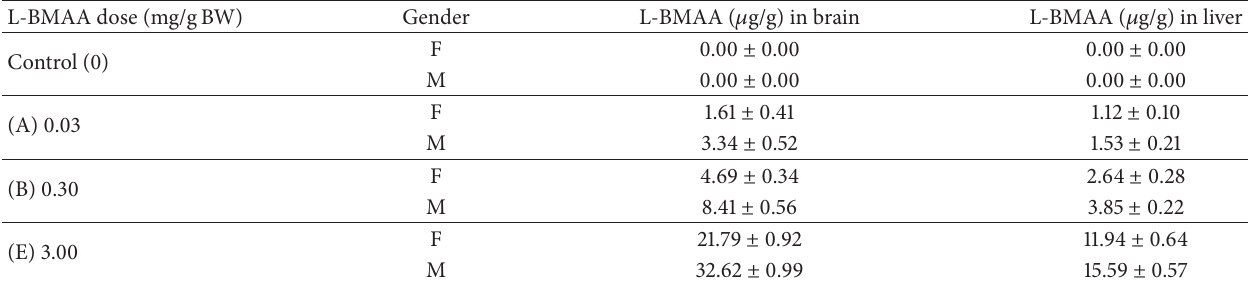
Table 4: L-BMAA concentrations ( 𝜇 g/g) in brains and livers of mice as detected by LC/MS/MS chromatography. Each value is the mean of three replicates ± standard deviation. BW: body weight; F: female; M: male. A, B, and E: mice treated (0.03, 0.3, and 3 mg/g BW) groups. L-BMAA dose